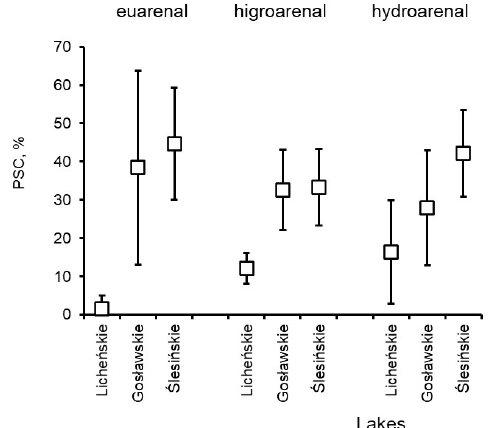
Figure 9. Percentage of psammon communities (PSC) of Rotifera from the 3 Konin Lakes compared to mean values calculated for rotifers from 17 Masurian Lakes (after [30]).